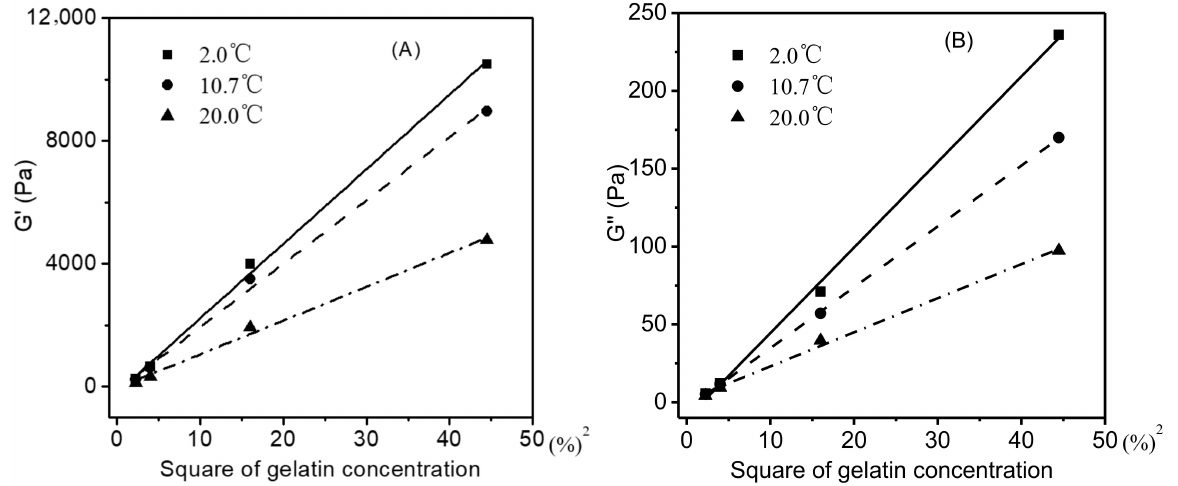
Figure 4. Square of gelatin concentration versus G (cid:48) of gelatin gels (2–20 ◦ C) ( A ), G (cid:48)(cid:48) ( B ). Figure 5 shows the changes of G (cid:48) and G (cid:48)(cid:48) during the cooling and subsequent heating stages of representative gelatin dispersions (using 6.67% gelatin dispersions as examples) as affected by the addition of LA, CA, and MA (0.5% and 2.0%). The rheological